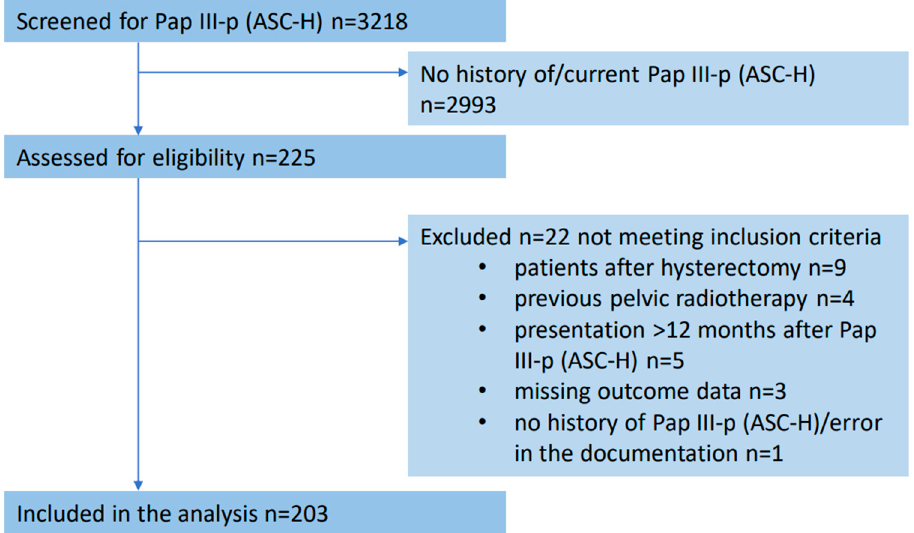
Figure 1. Patient Flow Diagram.